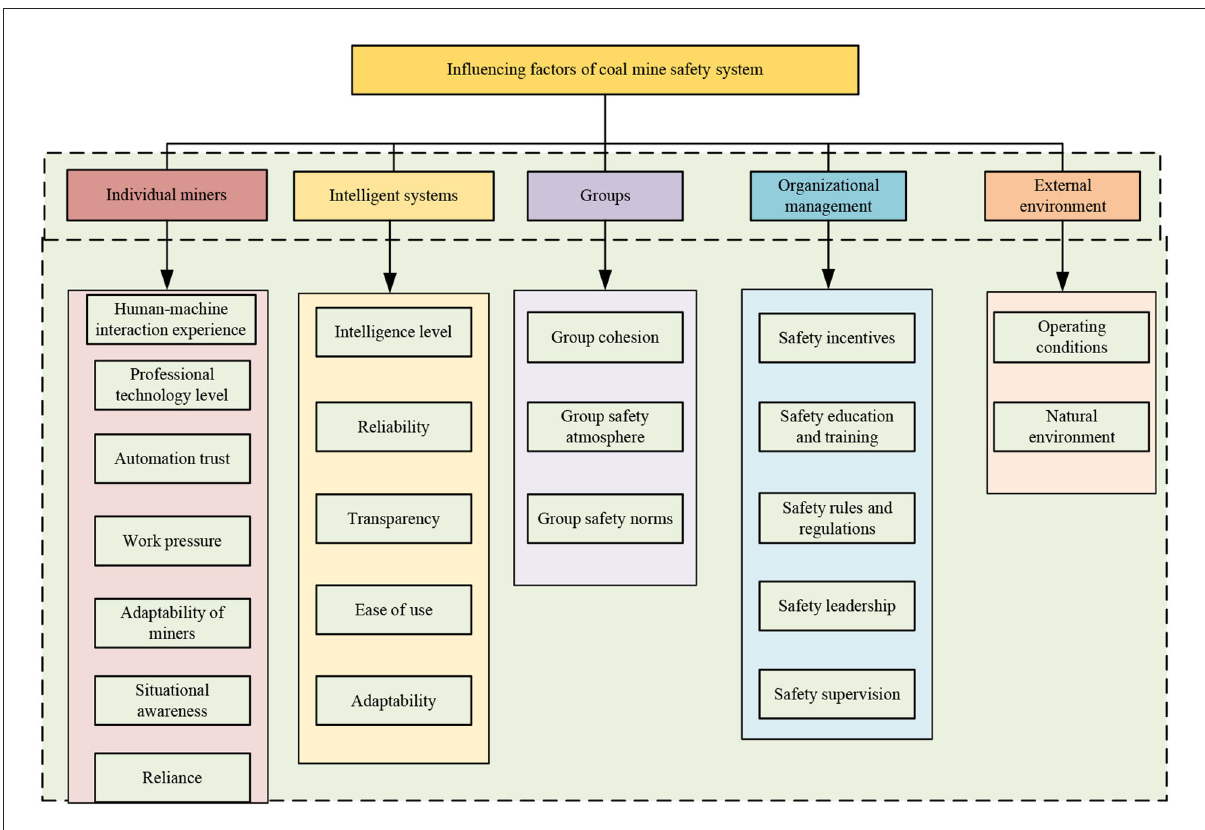
FIGURE1 Influencing factors of coal mine safety